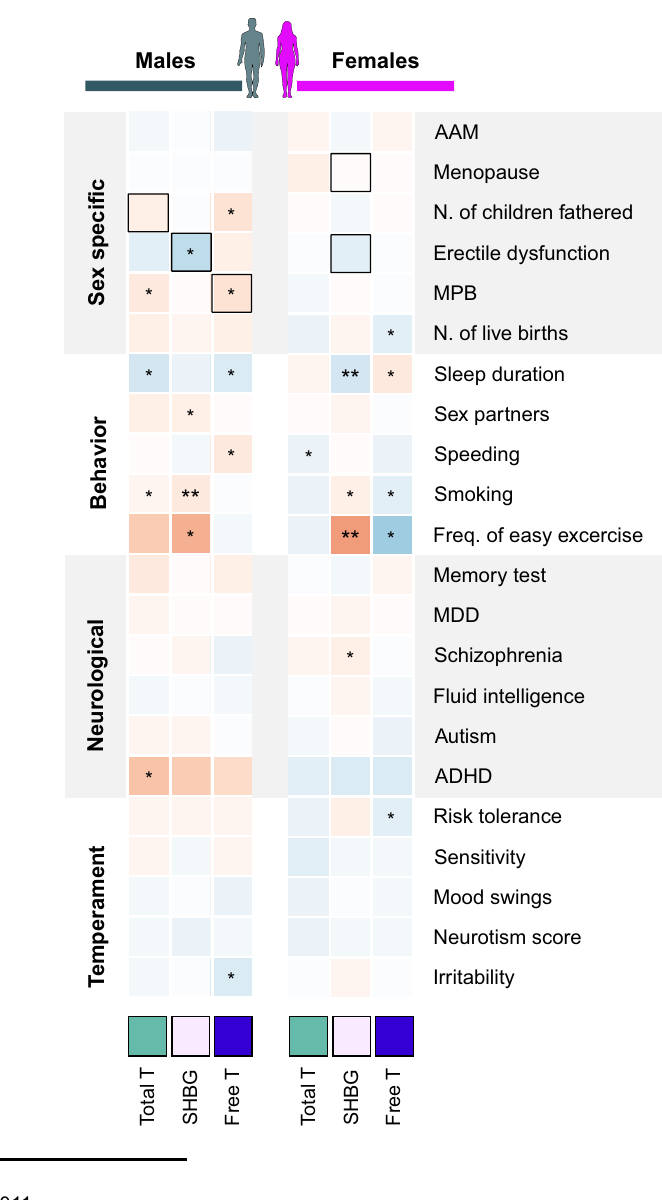
Genetic correlation (rg) * p<0.05, ** p<0.0011 LCV/MR Egger p <0.0011 −0.6 0 0.6 Fig. 5 Genetic correlation and causal relationships between the 44 traits and phenotypes from public GWAS data based on LDSC and MR analyses. The asterisks refer to signi fi cant genetic correlation between T/SHBG/free T and the studied phenotypes (* p < 0.05 and ** p < 0.0011, after Bonferroni correction for 44 independent tests). Dark green symbol = males, pink = females. Red shades in boxes refer to positive genetic correlation (the same genetic factors increase both traits), and blue shades to negative genetic correlation (genetic factors increasing one trait decrease the other). Genetic correlation does not necessarily imply causality. Black squares mark signi fi cant causal relationships between the tested traits based on LCV and MR Egger analyses. Data is based on GWAS summary statistics from studies ranging from 18,759 MDD cases to over a million participants in risk tolerance GWASs, most studies including several hundreds of thousands of subjects (Supplementary Data 11). Green = total testosterone, white lilac = SHBG, blue = free testosterone. AAM age at menarche, ALAT alanine transaminase, ADHD attention de fi cit and hyperactivity disorder, CHD coronary heart disease, GGT gamma-glutamyl transferase, HBMD heel bone mineral density, MDD major depressive disorder, MPB male pattern baldness, RA rheumatoid arthritis, RHGS relative handgrip strength, WHR waist-to-hip